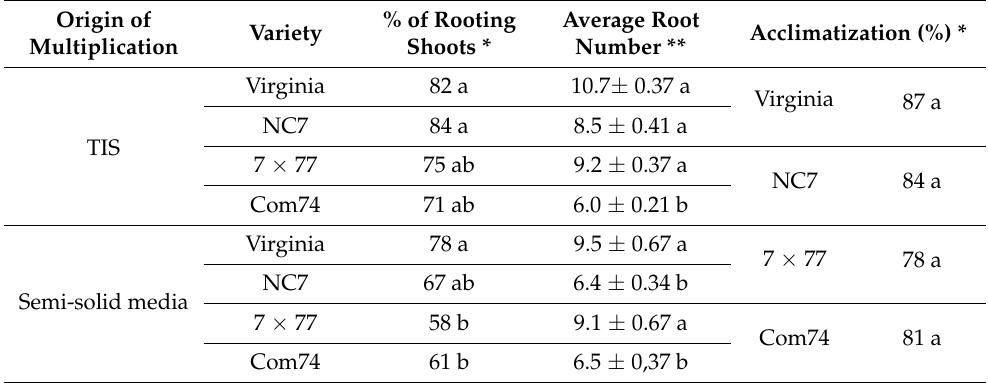
Table 6. Rooting performance of Arachis hypogaea L. shoots, previously multiplied in vitro either in liquid (in TIS) or on solid media and their acclimatization